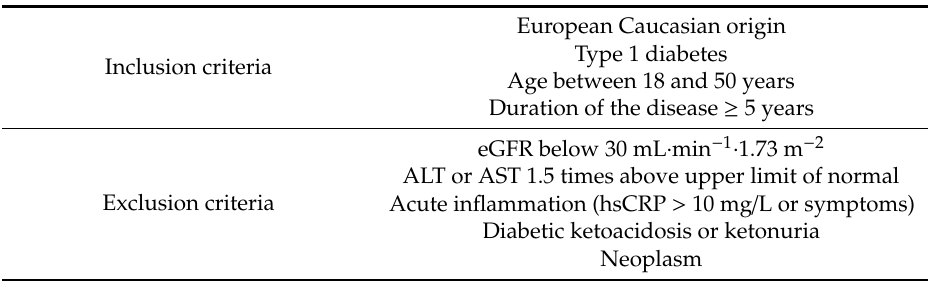
Table 1. Inclusion and exclusion